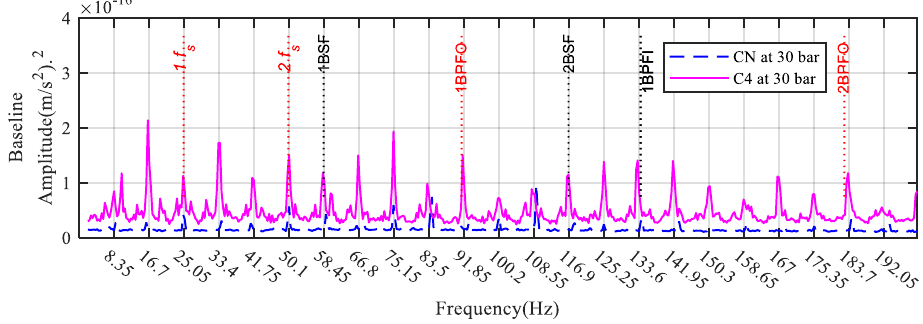
Figure 12. MSB slices for different clearances and local defects.